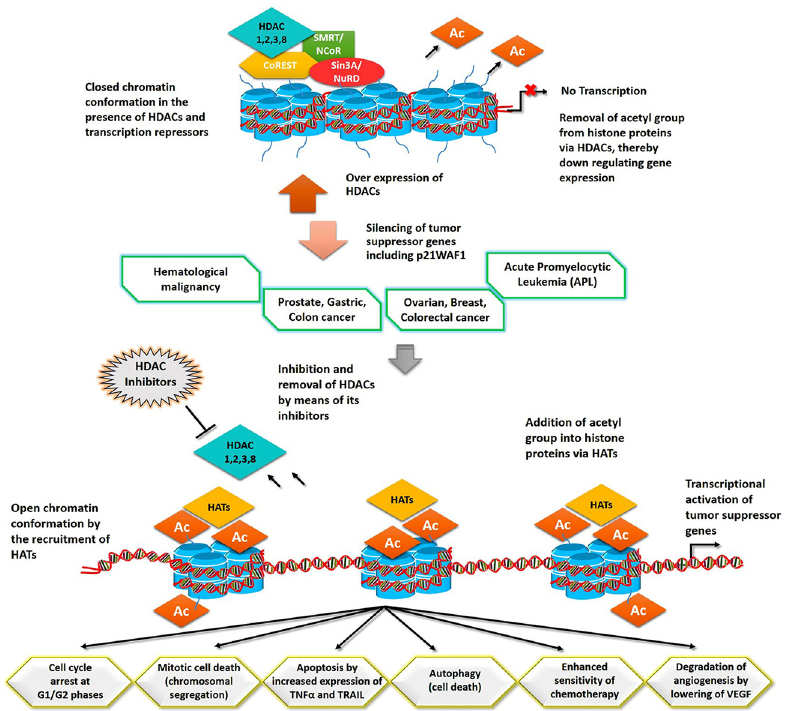
Fig 13. Disease association and inhibition mechanism of class I HDACs. Over expression of HDACs has been perceived in numerous cancers. Binding of drug-like molecules to the catalytic cavity of HDACs eradicates these enzymes from transcription initiation site and stimulates the inclusion of HATs. Acetylation of histones by means of HATs reactivates the transcription of tumor suppressor genes. Expression of these genes controls the abnormal cell growth by cell cycle arrest and mitotic cell death or escalation of apoptosis and autophagy. Tumor suppressor genes enhance the sensitivity of chemotherapy and restrict the process of angiogenesis by decreasing